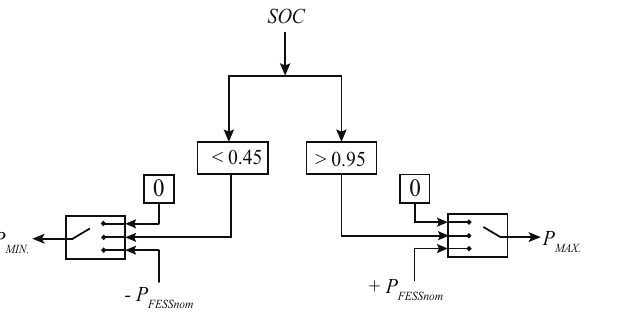
Figure 6. Maximum and minimum controllable power according to the Flywheel SOC.